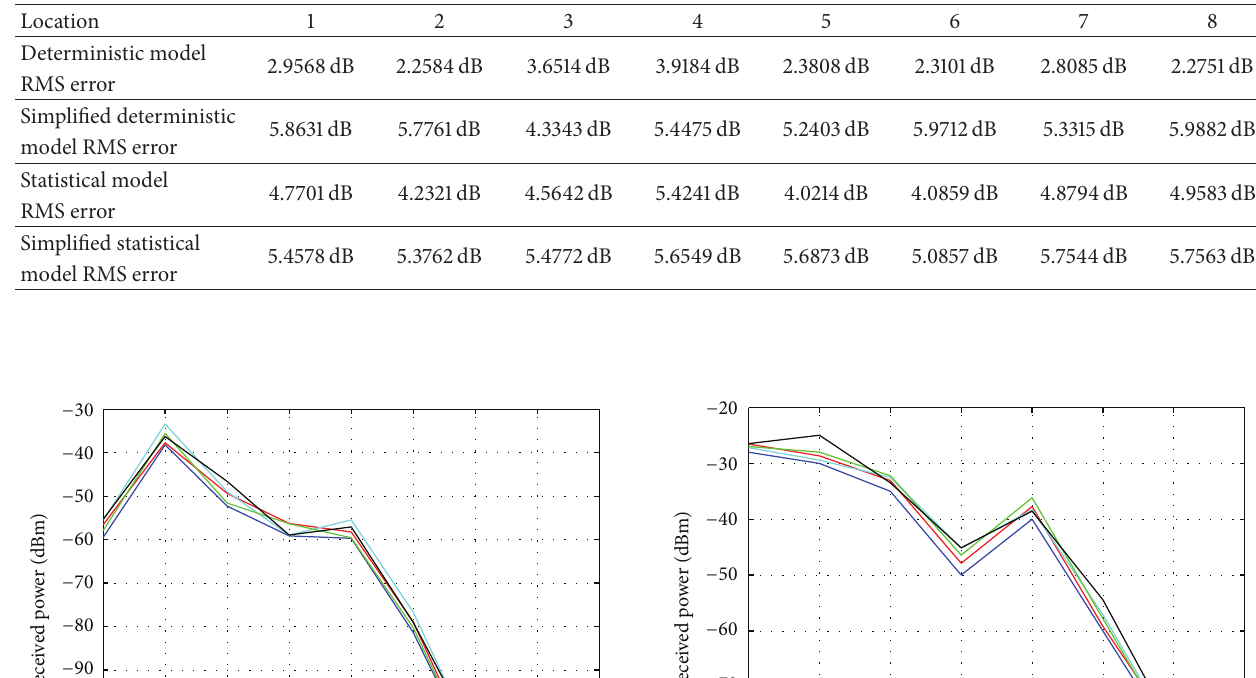
Table 4: Received signal power RMS error in uplink scenario.